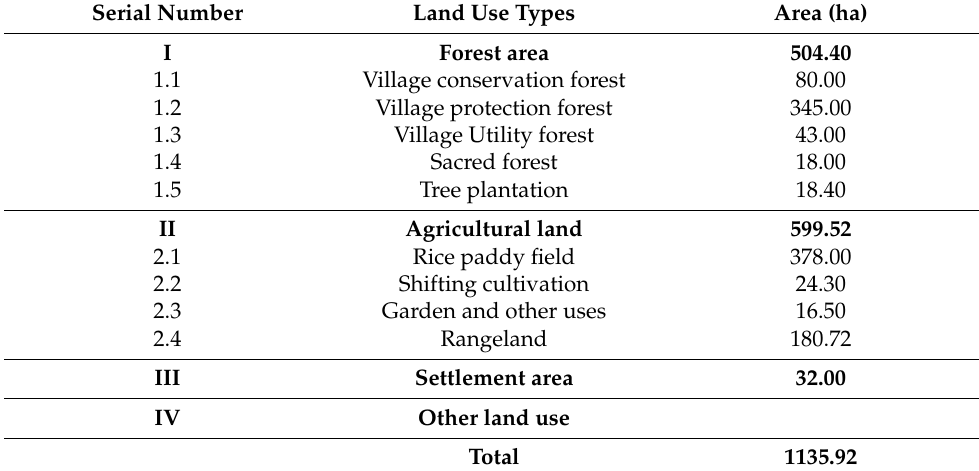
Table 1. Land use of Nongboua village.